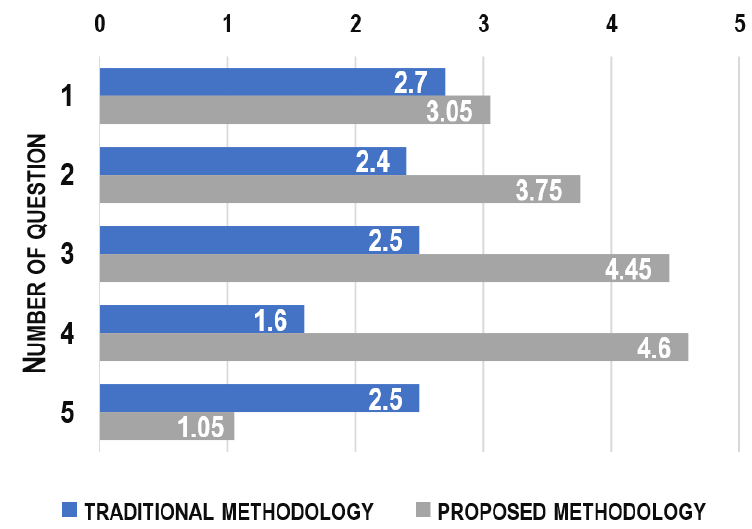
Figure 10. Survey Figure 10. Survey results.